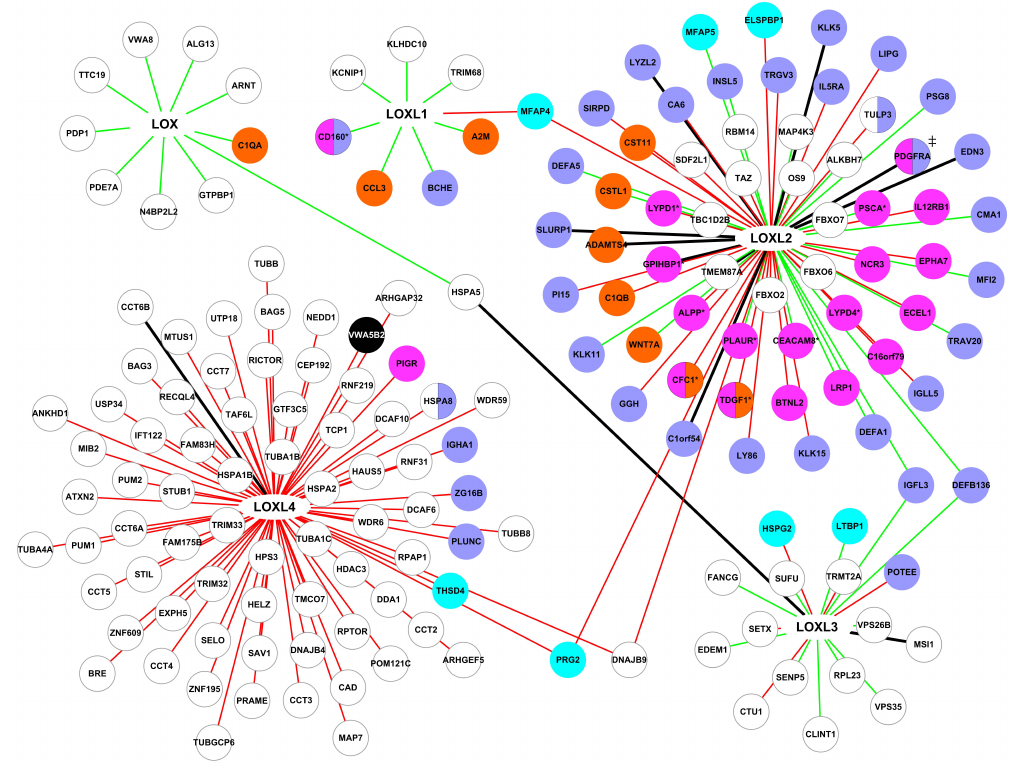
Figure 7. Interactions identified by AP-MS in HEK 293T cells and HCT 116 cells. Green lines: interactions specific to HEK 293 cells, red lines: interactions specific to HCT 116 cells, black lines: interactions found in both cell types. Proteins were color-coded as follows: cyan: core-matrisome proteins, orange: matrisome-associated proteins, purple: extracellular proteins not included in the matrisome, white with grey border: intracellular proteins, pink: membrane proteins, black: undetermined location. ‡: two different isoforms in normal and tumor cells. *: glycosyl-phosphatidylinositol-anchored